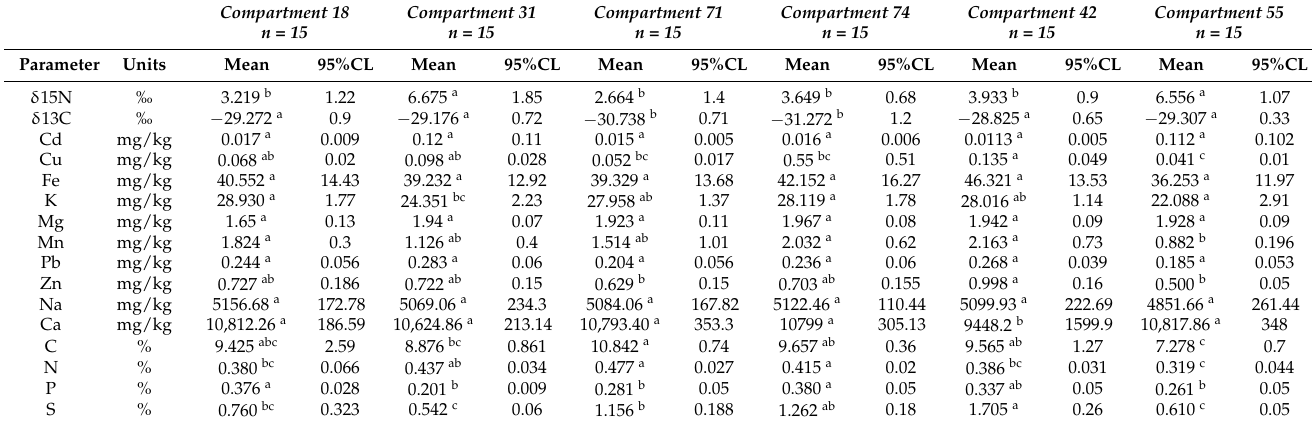
Table 3. The chemical composition of sediments from six compartments in 18, 31, 42, 71, 74, and